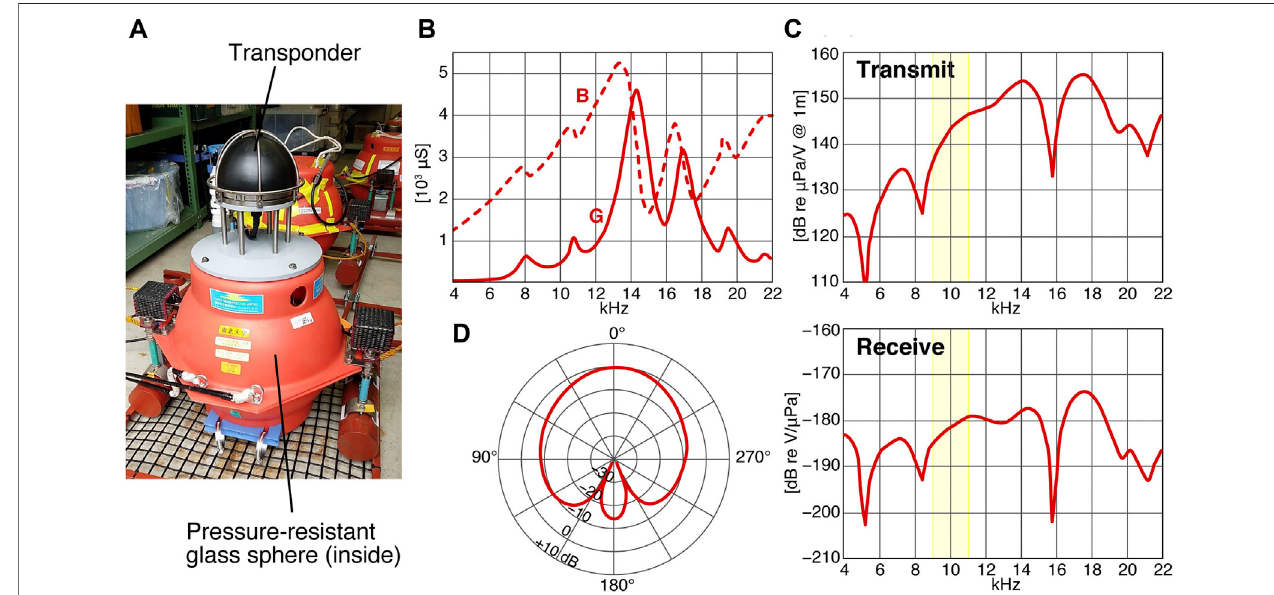
FIGURE 8 | Appearance of the sea fl oor station (A) and product speci fi cations of the transponder: in-water admittance (G: conductance; B : susceptance) vs. frequency (B) , transmitting (top) and receiving (bottom) sensitivity (C) , and directivity pattern at 10 kHz (D) .